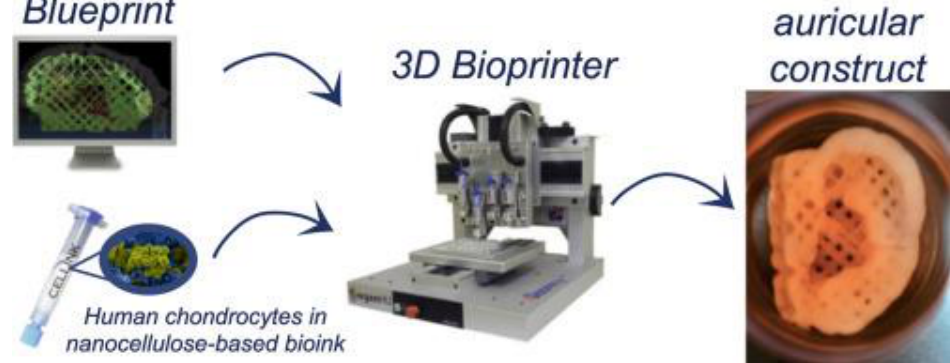
Figure 2. 3D bioprinting process of chondrocyte-laden NFC-A auricular constructs with open porosity. Adopted from [172] with permission.